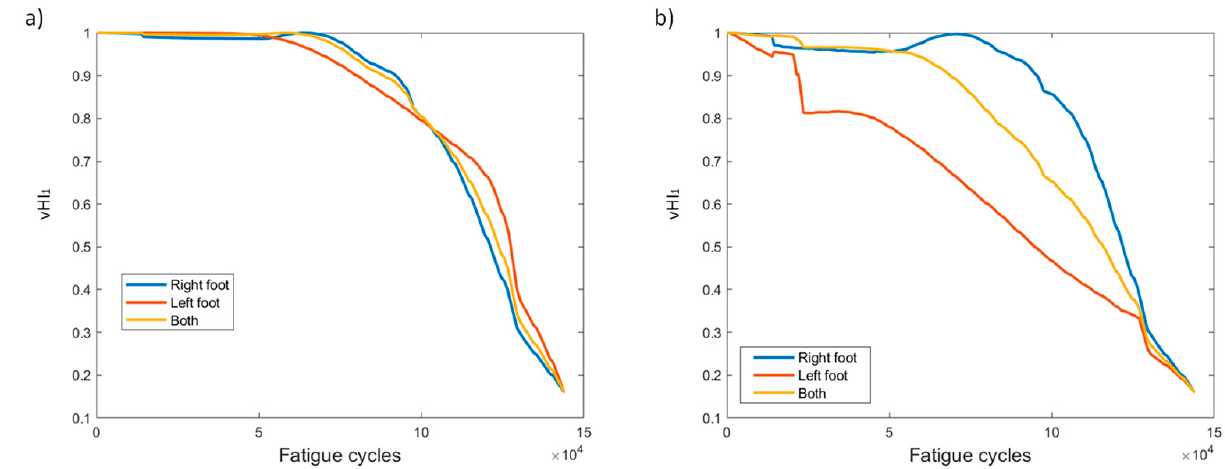
Figure 9. vHI 1 progression through time for the two pre-processing methods for specimen CA-2: ( a ) method 1, ( b ) method 2.